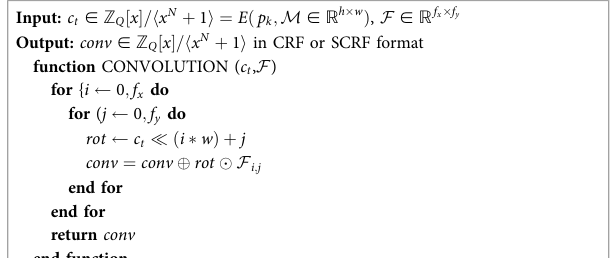
Algorithm 11 2D Convolution